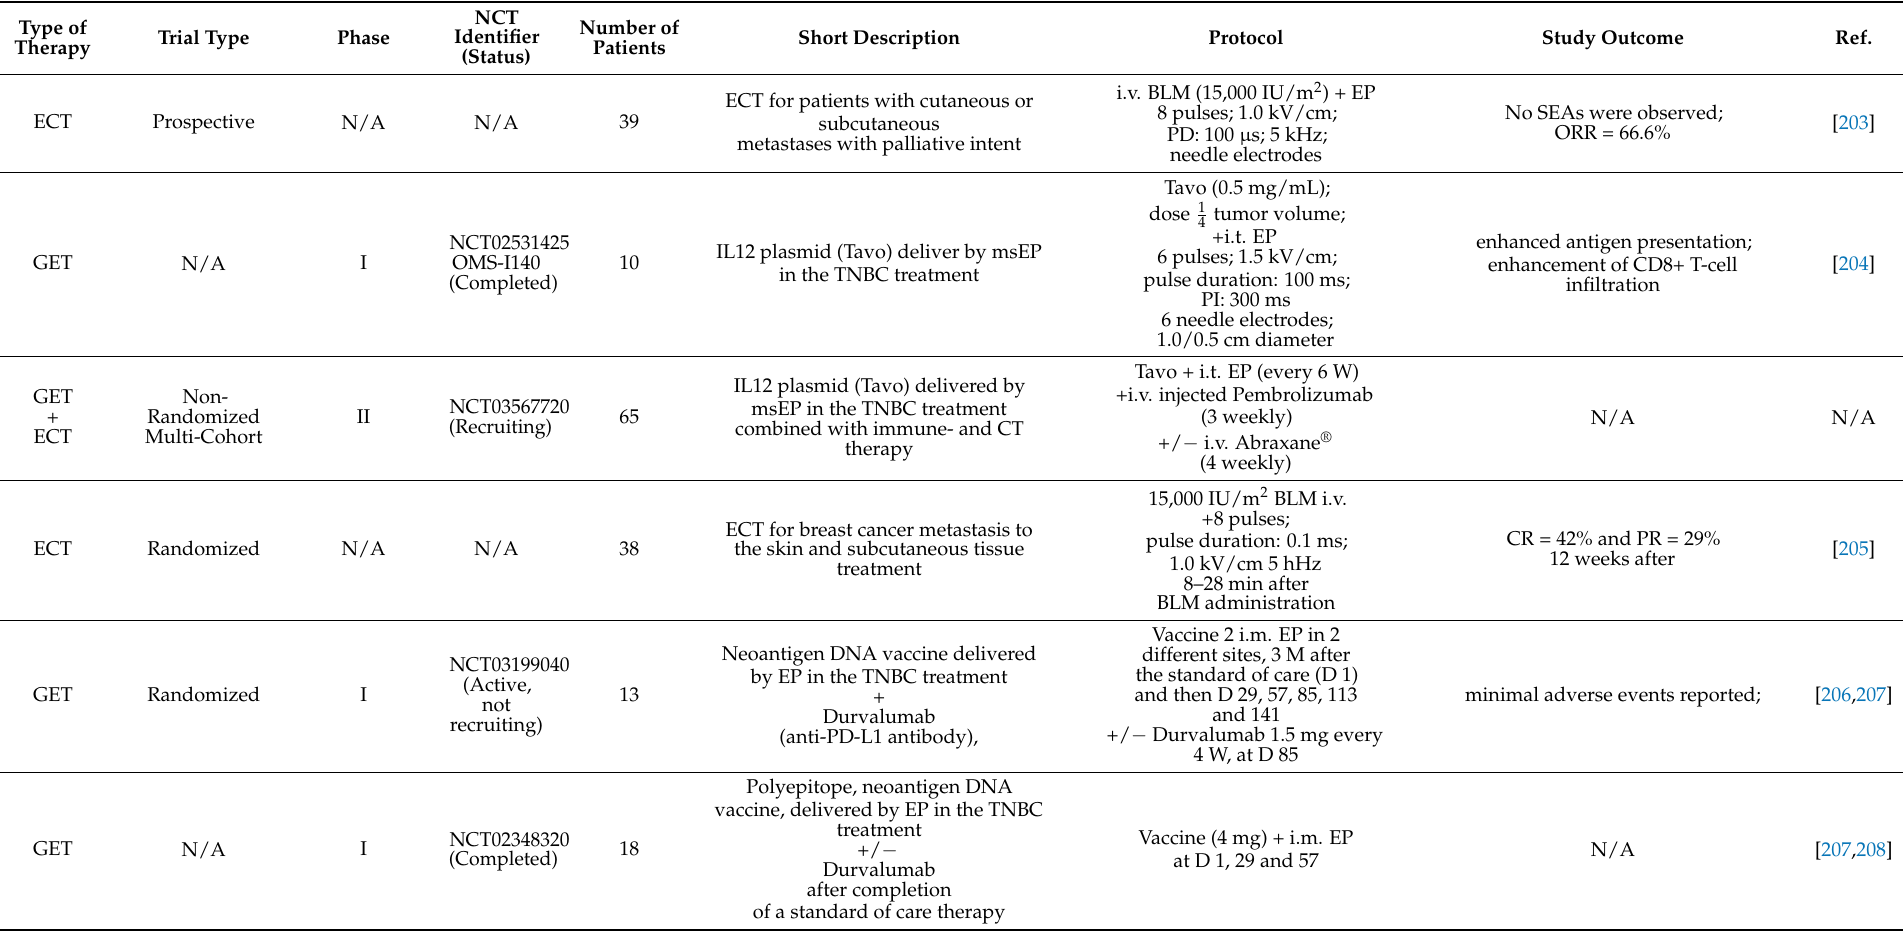
Table 3. Clinical trials and case reports focusing on the use of EP-based therapies in breast carcinoma